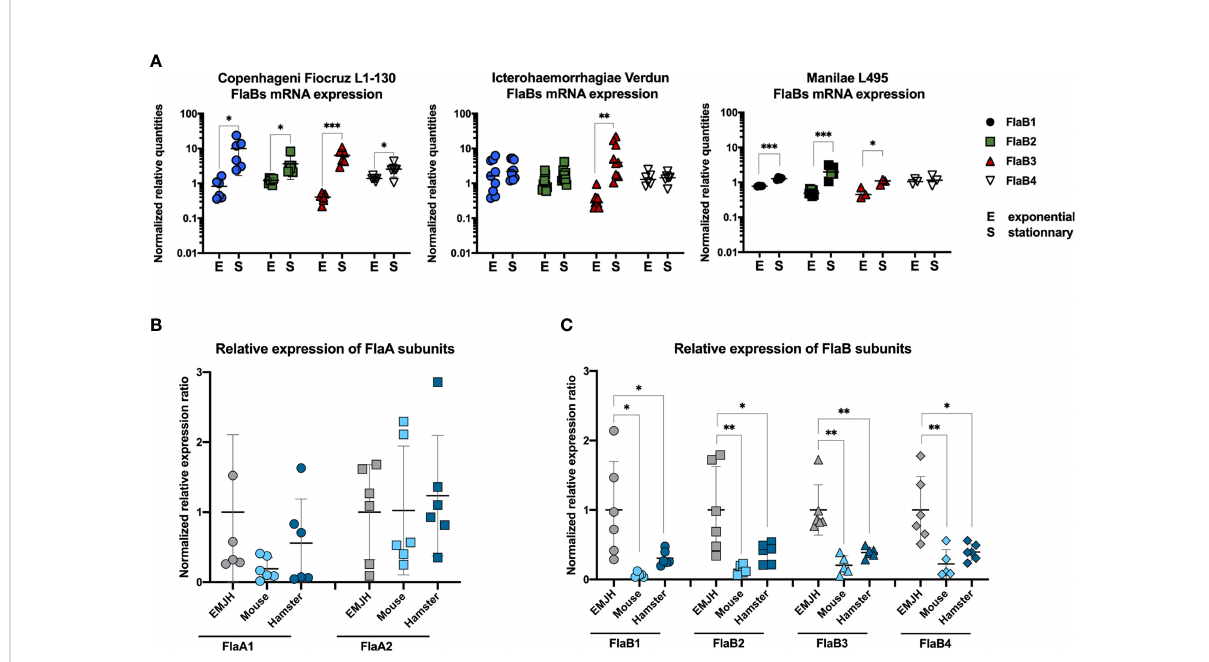
FIGURE 8 (A) In vitro FlaBs mRNA expression in L. interrogans Copenhageni Fiocruz L1-130, Icterohaemorrhagiae Verdun and Manilae L495 at the exponential (E) and stationary (S) phase. Data of RT-qPCR are expressed as the relative mRNA quantities normalized to the expression of the lipl41 mRNA. Technical replicates are represented as dots and lines correspond to mean (+/- SD) of replicates (3 < n < 9). Statistically signi fi cant differences (Student t-test) are indicated. (B) In vivo FlaAs and (C) FlaBs mRNA expression in blood of infected mice (n=5, light blue) and hamsters (n-5, dark blue), 24 h post intraperitoneal infection with 2x108 virulent L. interrogans Icterohaemorrhagiae strain Verdun, compared with mRNA expression in culture in EMJH at 30° C. Data of RT-gPCR are expressed as the ratio of mRNA quantities relatives to the EMJH control. Individual animals are represented as dots and lines correspond to mean (+/- SD) of all animals. Statistically signi fi cant differences (Student t-test) are indicated with corresponding p values: * for p < 0.05; ** for p < 0.01 and *** for p <